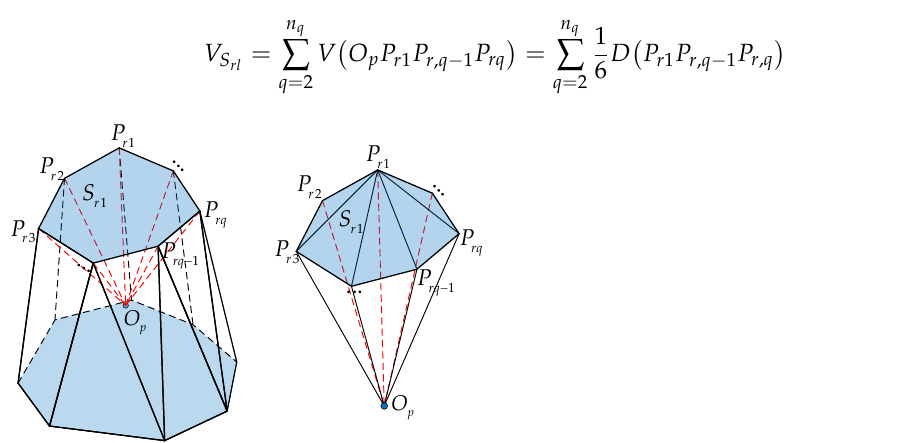
Figure 8. CPH decomposition and face decomposition.